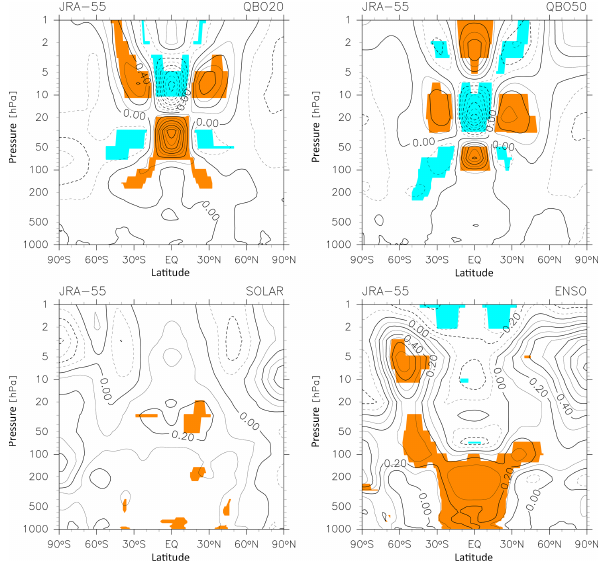
Figure 1. Latitude–pressure distribution of the temperature varia- tions in association with (top left) QBO 20hPa zonal wind index, (top right) QBO 50hPa zonal wind index, (bottom left) solar cy- cle index, and (bottom right) ENSO index from JRA-55 reanalysis data for the period 1979–2009. The units are in Kelvin per standard deviation (SD) of each index (note that each index time series was standardized before the regression analysis). Solid and dashed lines denote positive and negative values, respectively. The contour inter- val is 0.2K for QBO, and 0.1K for solar cycle and ENSO. Coloured regions denote those greater (orange) and smaller (blue) than ran- dom variations with the 95% confidence interval at each